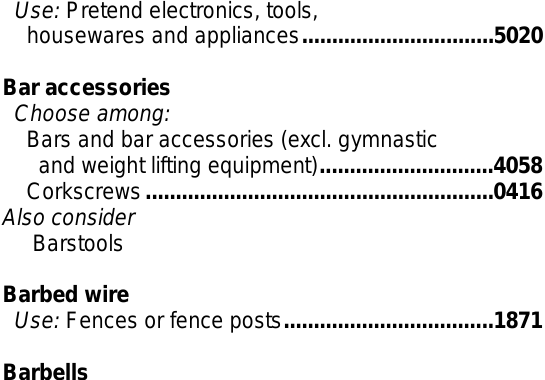
Ballot box Use : Public use item not elsewhere classified .... 1738 Balls If ball is used in a specific sport or game, use the code for that sport or game. Beach balls Bouncy balls, if used as a riding toy, Bouncy balls, not used as a riding toy, Bumper balls Medicine balls Use: Exercise equipment (excl. weight Other ball sports (activity/apparel/equipment) .... 3235 Yoga balls Use: Exercise equipment (excl.